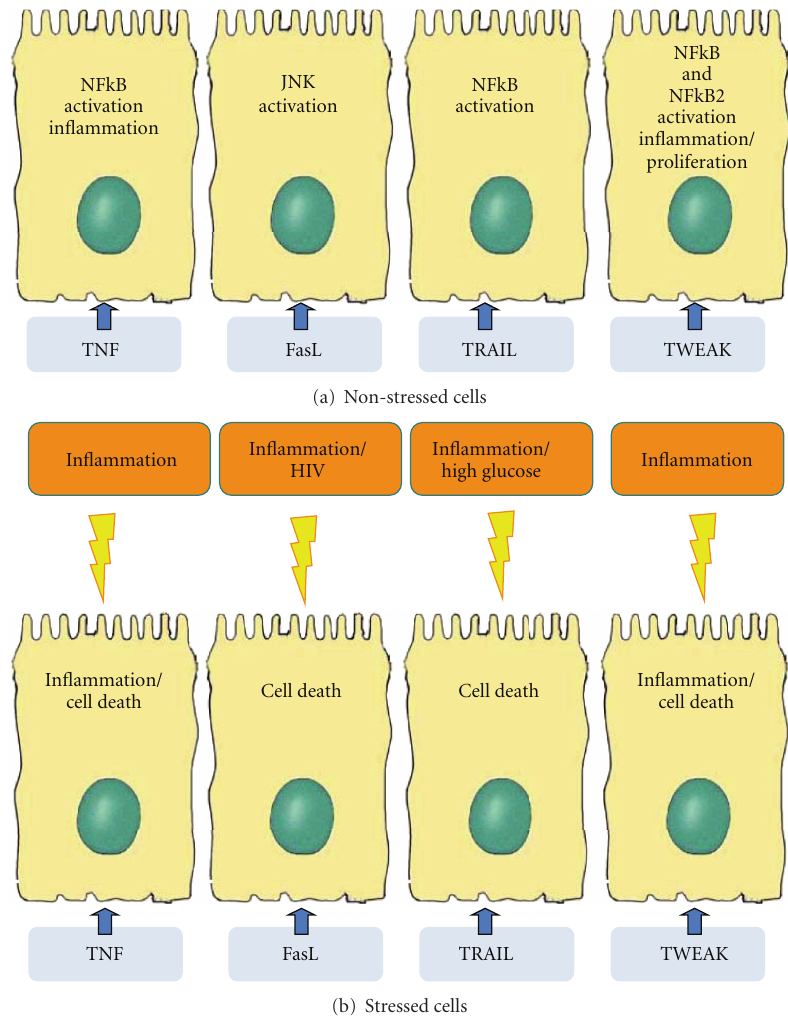
Figure 1: Schematic representation of TNFSF cytokine actions on tubular renal cells. The microenvironment influences the cell response. Among the many potential microenvironmental factors, we have highlighted those more consistently shown to modulate the cell response to a particular cytokine. The localization of the receptors has been best characterized for Fas and shown to be present in the basolateral membrane. This does not exclude expression in the apical membrane under certain circumstances. Proximal tubular cells are presented since they have been most extensively studied, but TNFSF cytokines also have actions on other tubular cells, glomerular cells, endothelial cells, leukocytes, and